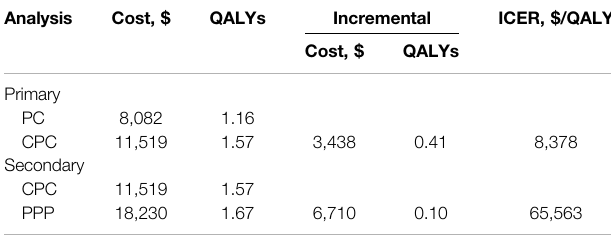
TABLE 2 | Summary of simulation